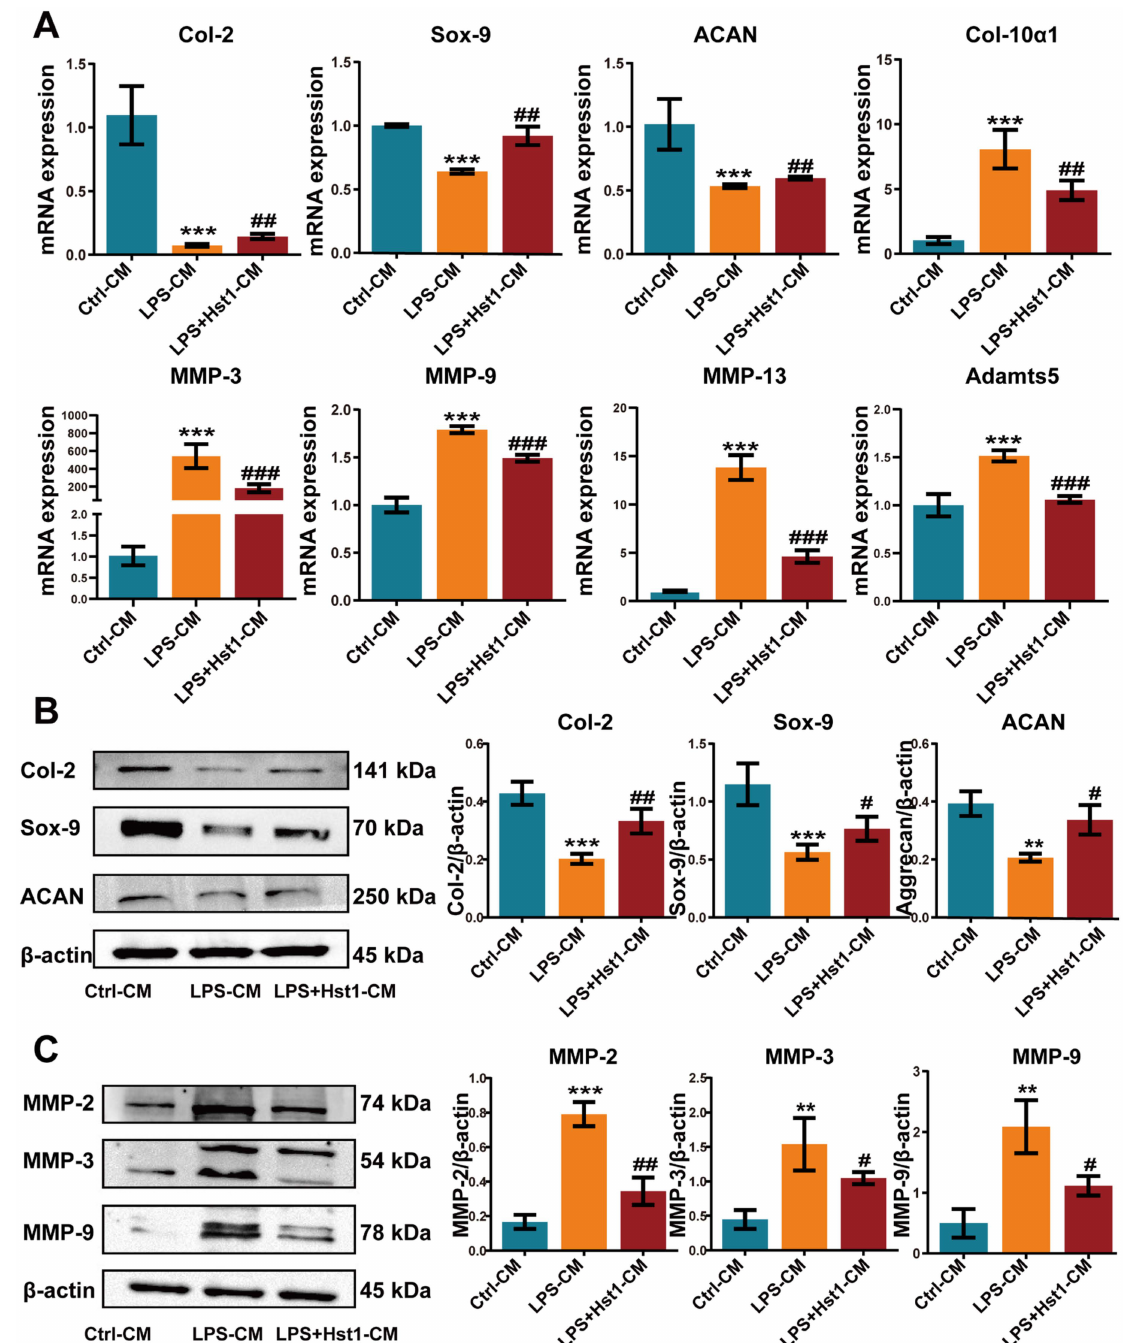
Figure 9. CM from Hst1-treated macrophages promoted ATDC5 cell differentiation and reduced chondrocyte destruction. ( A ) RT-qPCR results of chondrogenic differentiation markers Col-2, Sox- 9, Aggrecan, and cartilage catabolism-related markers MMP-3, MMP-9, MMP-13, and Adamts5. ( B ) Western blot analysis and quantification of chondrogenic markers Col-2, Sox-9, and Aggrecan, and cartilage catabolism-related markers MMP-2, MMP-3, and MMP-9. ( C ) ATDC5 cells were cultured with macrophage CM for 7 days. Blots are cropped from Supplementary File S3. Data are expressed as means ± SD from three independent experiments. Significant differences compared to the control-CM group: ** p < 0.01 and *** p < 0.001, and compared to the LPS-CM group: # p < 0.05, ## p < 0.01, and ### p <